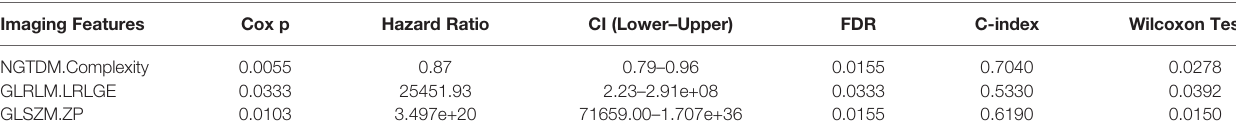
TABLE 3 | Imaging features with signi fi cant prognostic value for OS. Imaging Features